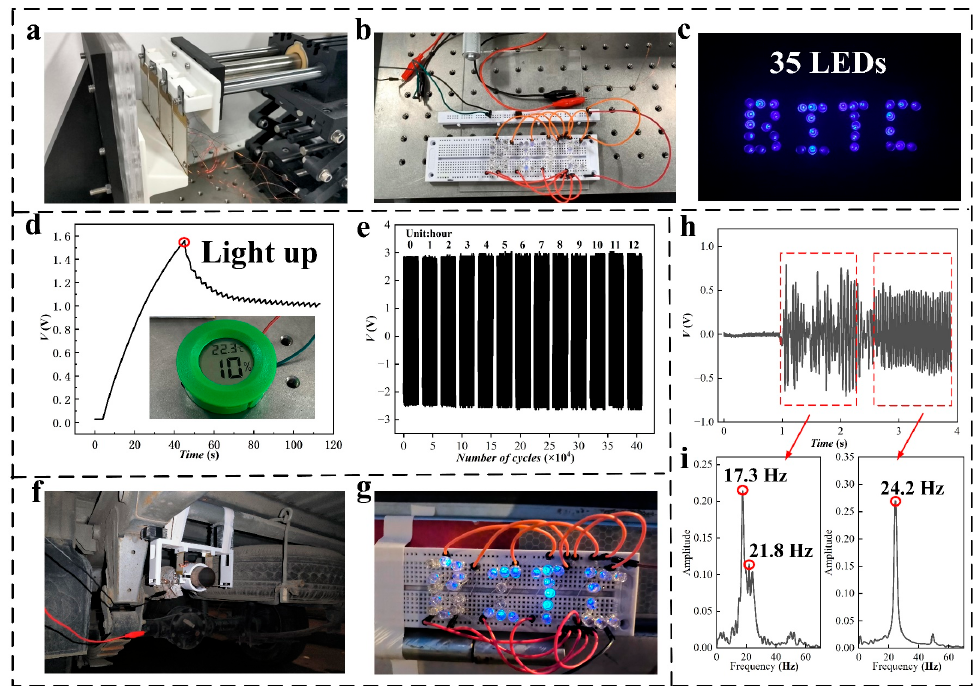
Figure 6. Application experiment of the SPID: ( a ) piezoelectric generator driven by a linear motor; ( b , c ) wiring of the LED lamp and photograph after lighting; ( d ) capacitor charging curve and sensor are driven; ( e ) PZT unit operates for 430,000 cycles; ( f , g ); intelligent device collecting the vibration energy of the automobile exhaust system and lighting up a warning lamp; ( h , i ) piezoelectric generating unit monitoring mechanical vibration signals.